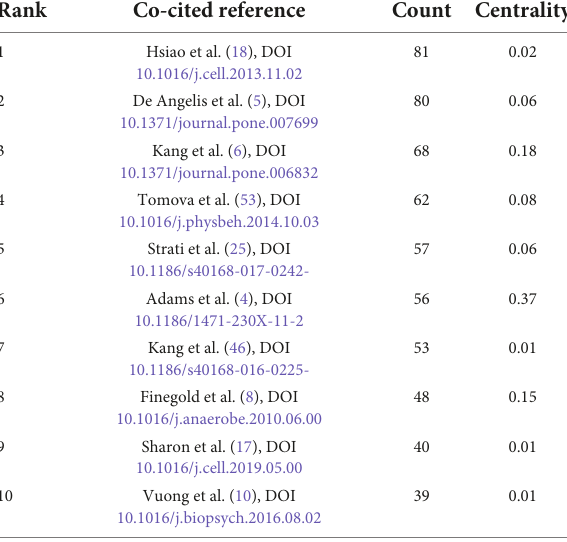
glutathione depletion, and altered phospholipid/acylcarnitine profiles